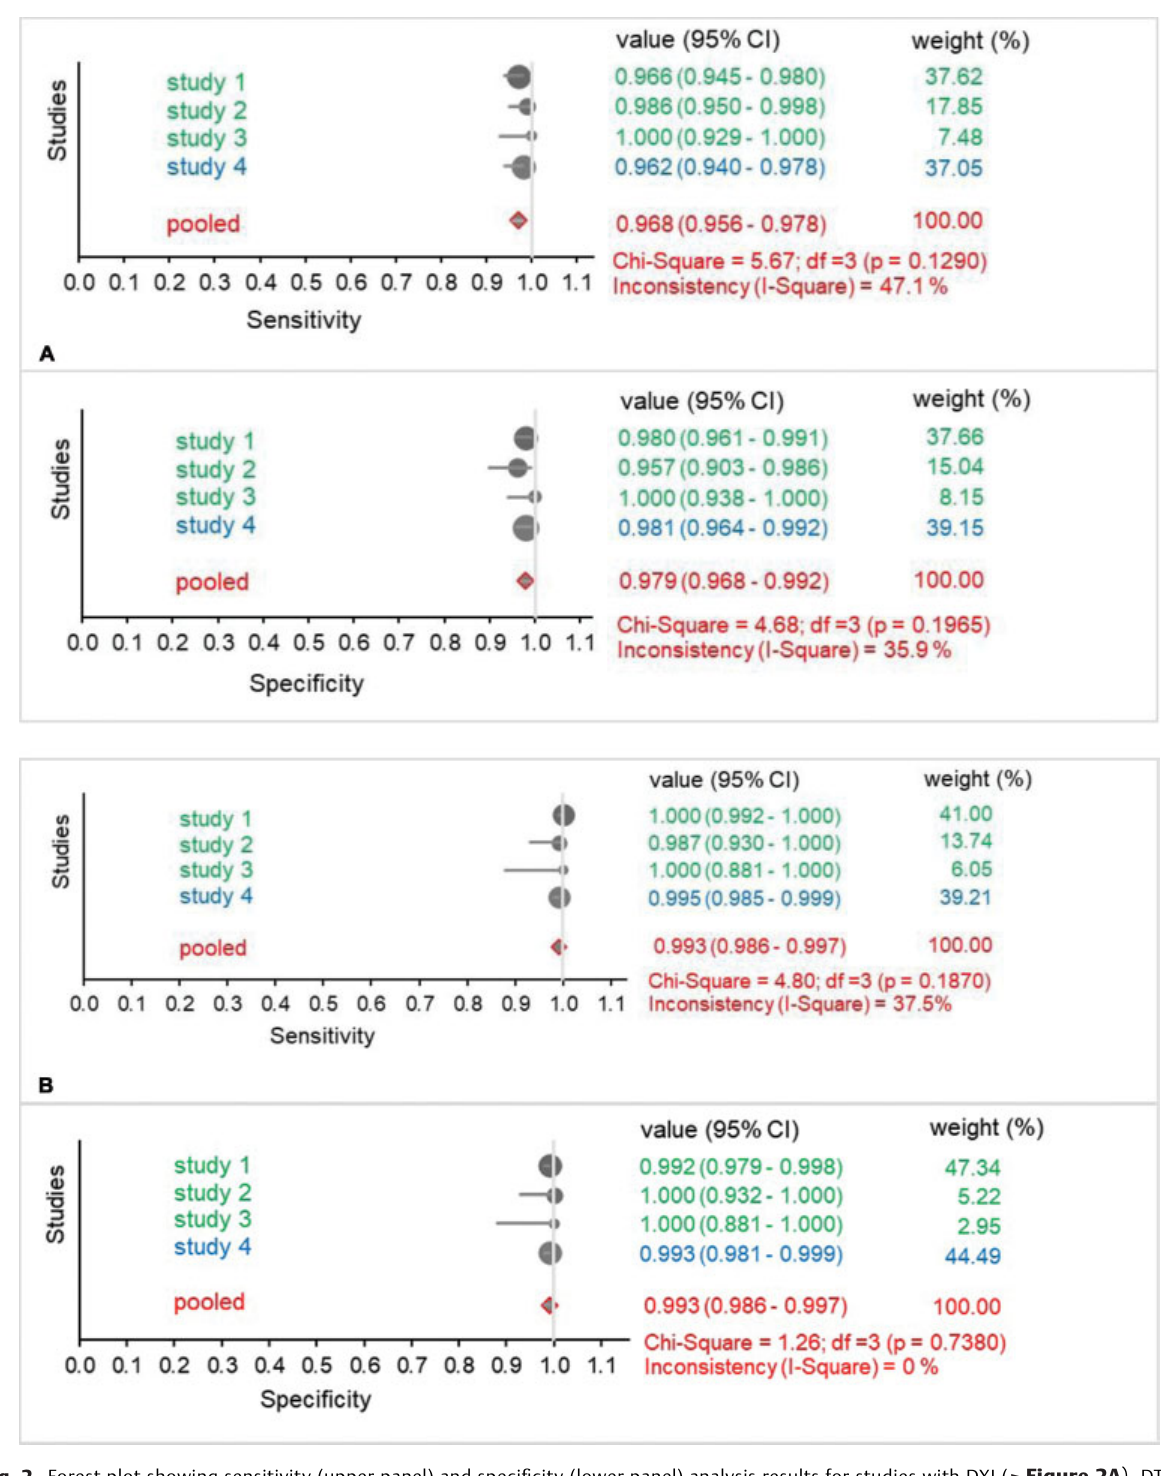
TH Open Vol. 5 No. 3/2021 © 2021. The